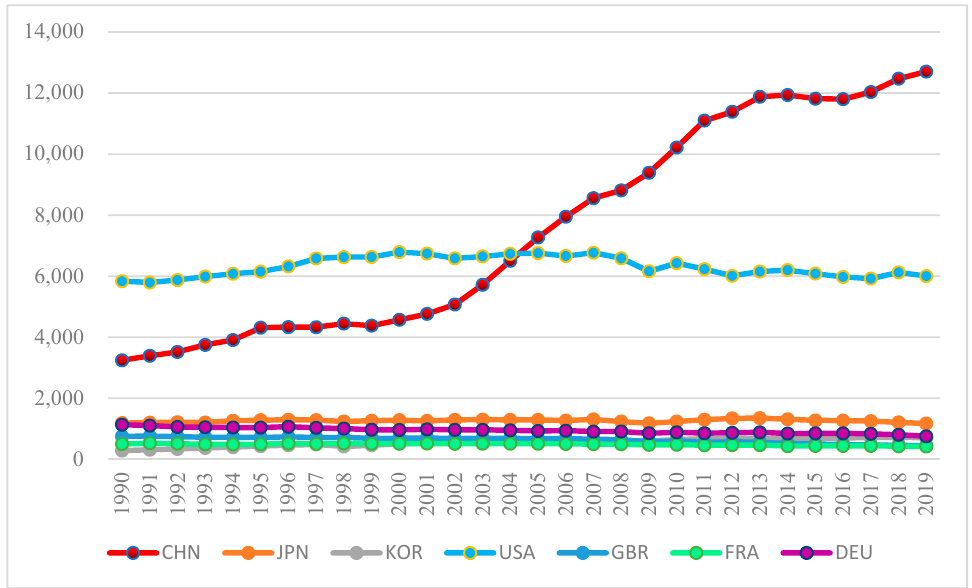
Figure 1. 1990–2019 CO 2 emissions of representative countries in the world (MT of CO 2 equivalent). Data source: World Bank/ourworldindata.org.